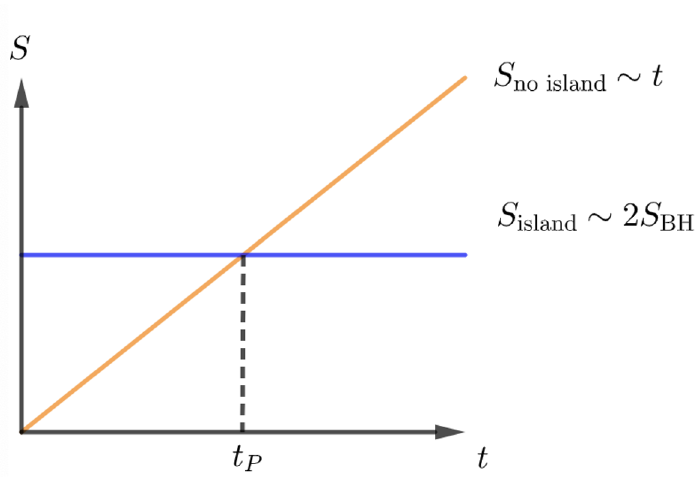
Figure 7 . Penrose diagram for the extremal surface (orange curve) passing through the horizon. Here z = z s denotes black hole singularity. We have z s = ∞ for λ GB ≥ 0 and z s = for λ GB < 0 . z max is the turning point of extremal surface.